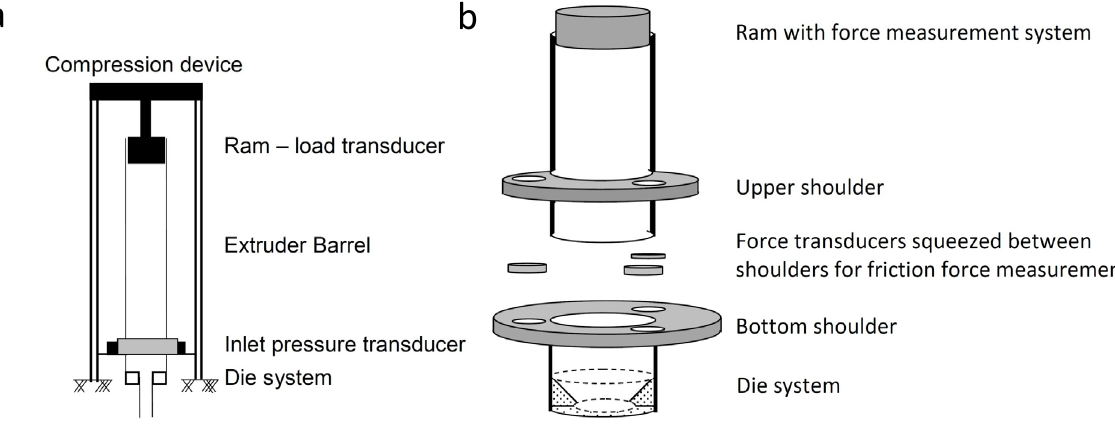
Figure 1. Ram extruder test setups with a) inlet pressure measurement as in [12], b) friction force measurement as in [13].